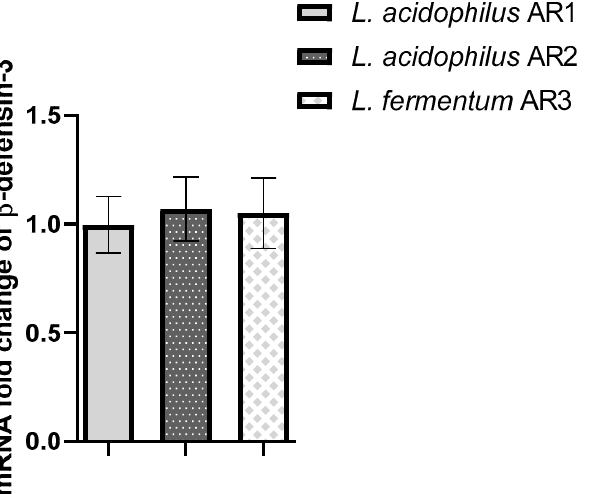
Figure 14. Modulatory effects of L. acidophilus AR1 ( A ), L. acidophilus AR2 ( B ), and L. fermentum AR3 ( C ) on different gene expression during pathogenic infection. Different letters show significant values